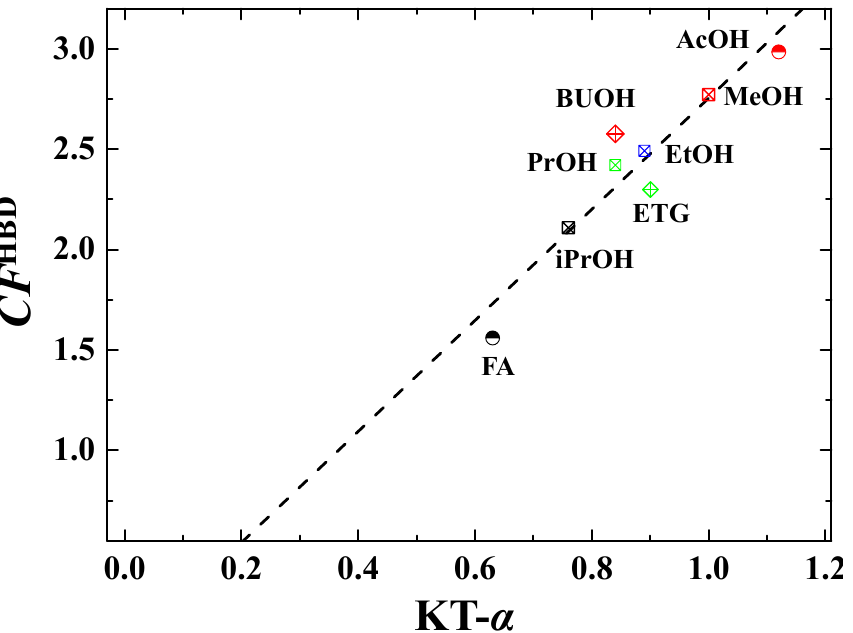
Solvent abbreviations for HBD cosolvent are given in Table 1. Solvent abbreviations for HBA cosolvent: ACN = acetonitrile; THF = tetrahydrofuran; GBL = gamma butyrolactone; GVL = gamma valerolactone;